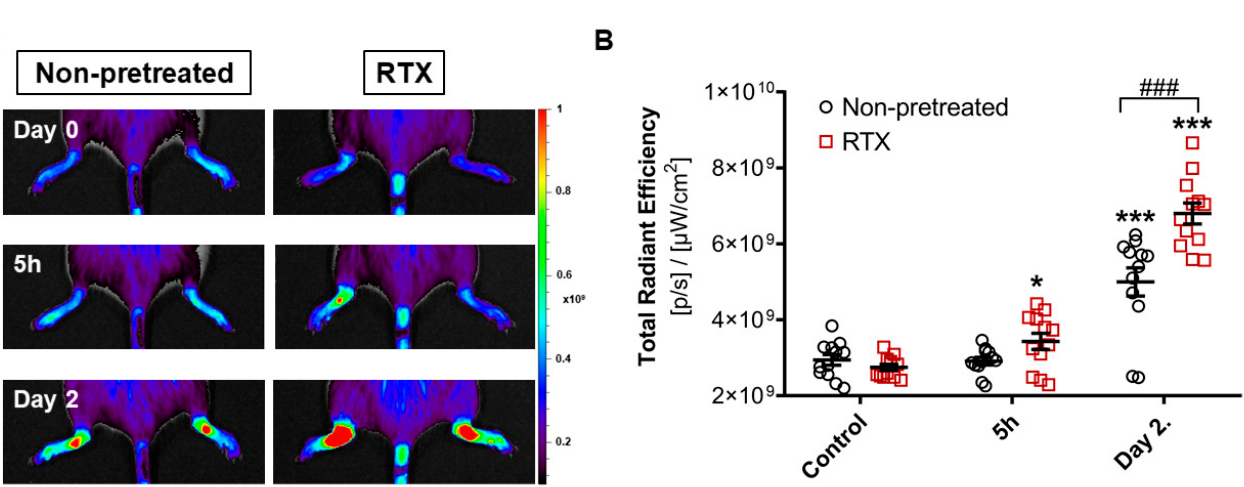
Figure 3. Inflammatory vascular hyperpermeability measured by in vivo fluorescence imaging and a vascular leakage probe. ( A ) Representative images. ( B ) Fluorescence signal of the ankle joints. Individual values are shown together with the means ± SEM of n = 6 per group both hindlimbs; two-way ANOVA and Fishers LSD test, * p < 0.05, *** p < 0.001 vs. self-control values before arthritis induction, ### p < 0.001 vs. non-pretreated arthritic group.